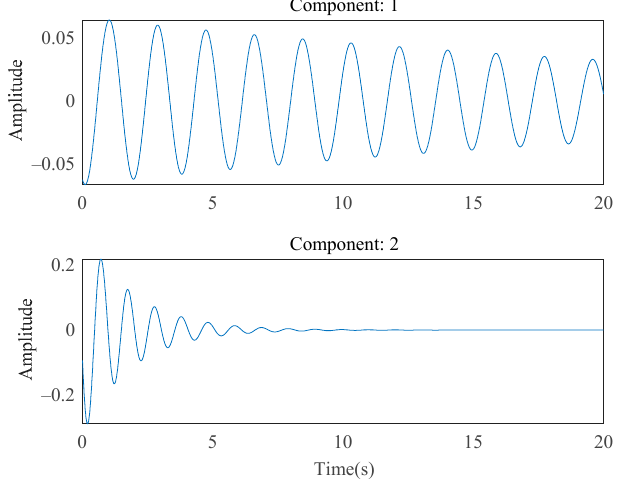
Figure 18. Dominant components of real-time signal identified by SMPI.